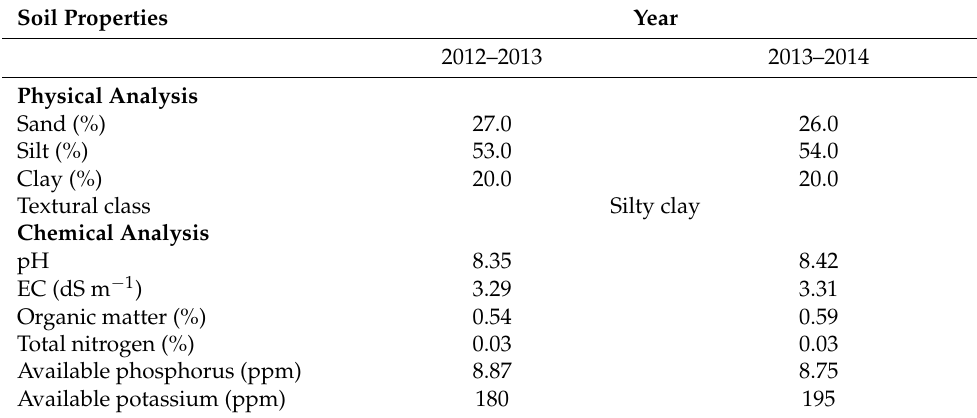
Table 1. Soil physico-chemical properties of experimental